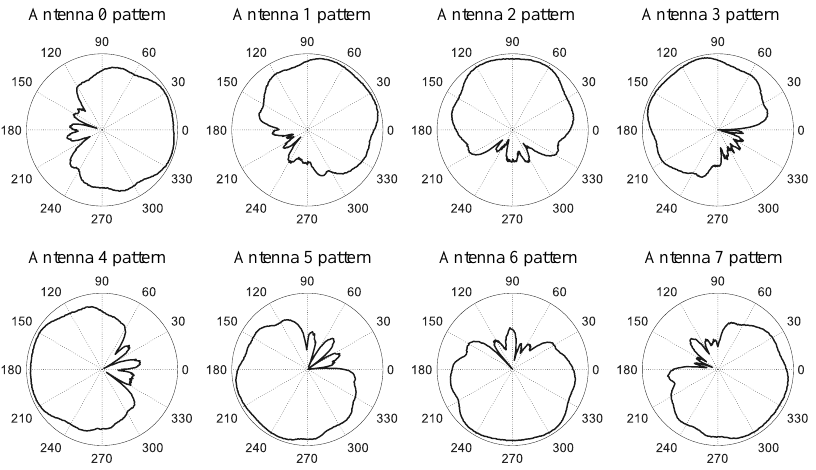
Figure 9. Antennas azimuth patterns.